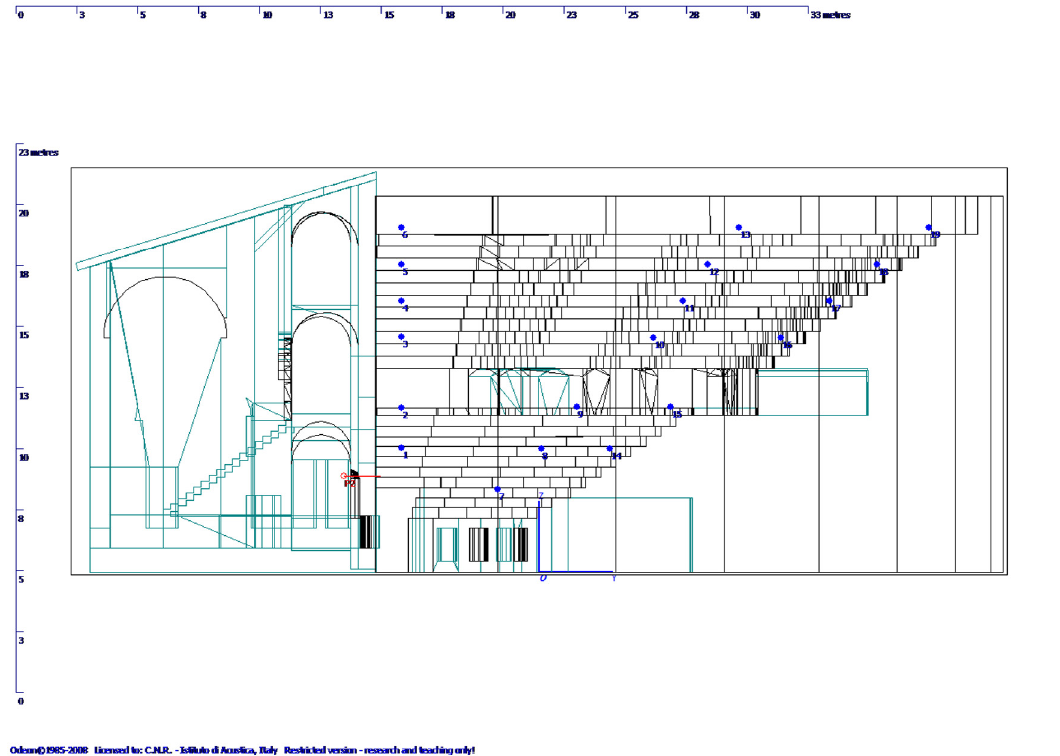
Figure 3. Side view of the 3D model of the theatre of the Pythion at Gortyna with source (red point) and receivers (blue